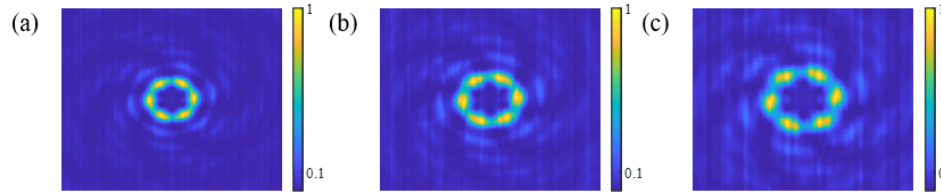
Figure 9. The intensity distributions of the CSZPG with the parameter of ( a ) f = 200 mm, ( b ) f = 250 mm and ( c ) f = 300 mm.